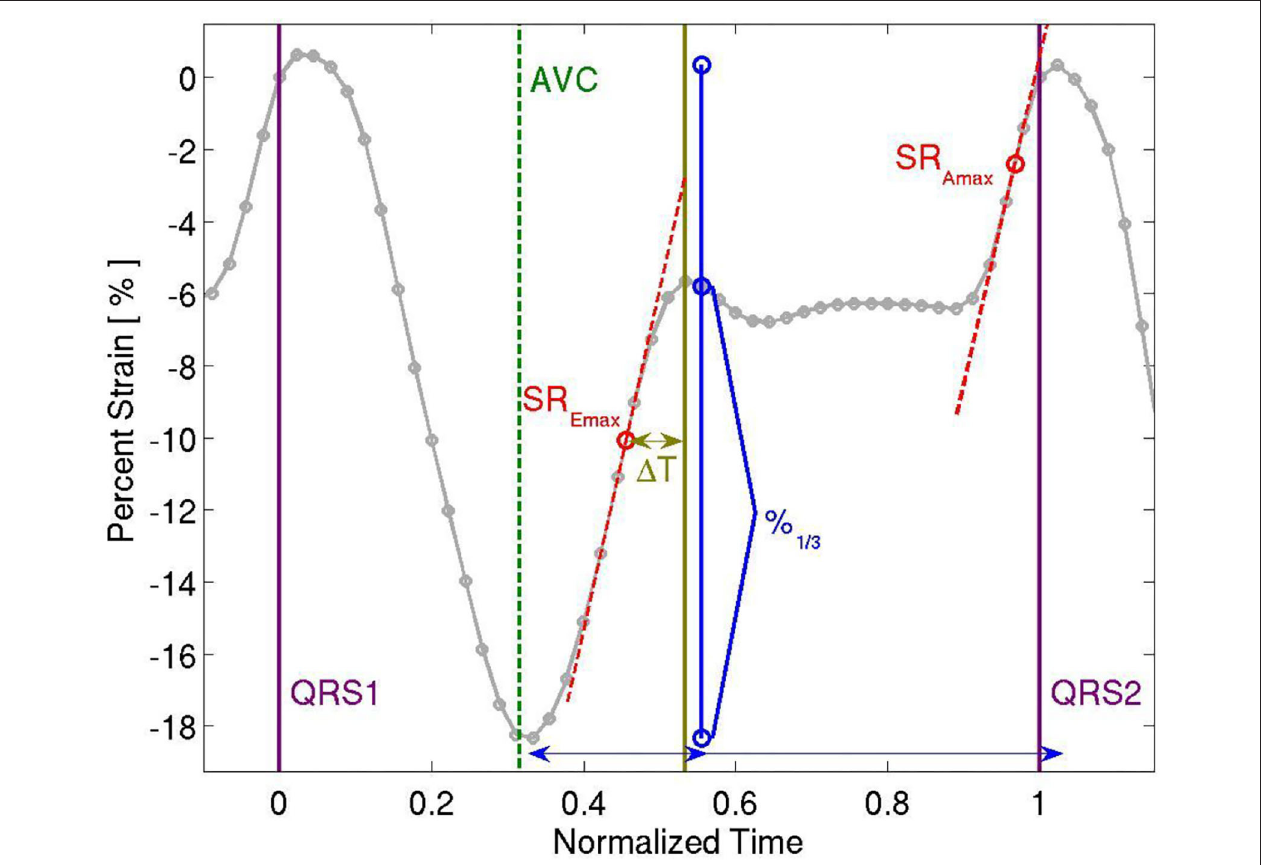
FIGURE 1 | Representative Strain Curve showing time to peak longitudinal strain, peak longitudinal strain, peak early and late diastolic strain rate (SR Emax and SR Amax, respectively), and peak diastolic strain rate deceleration time ( 1 T).